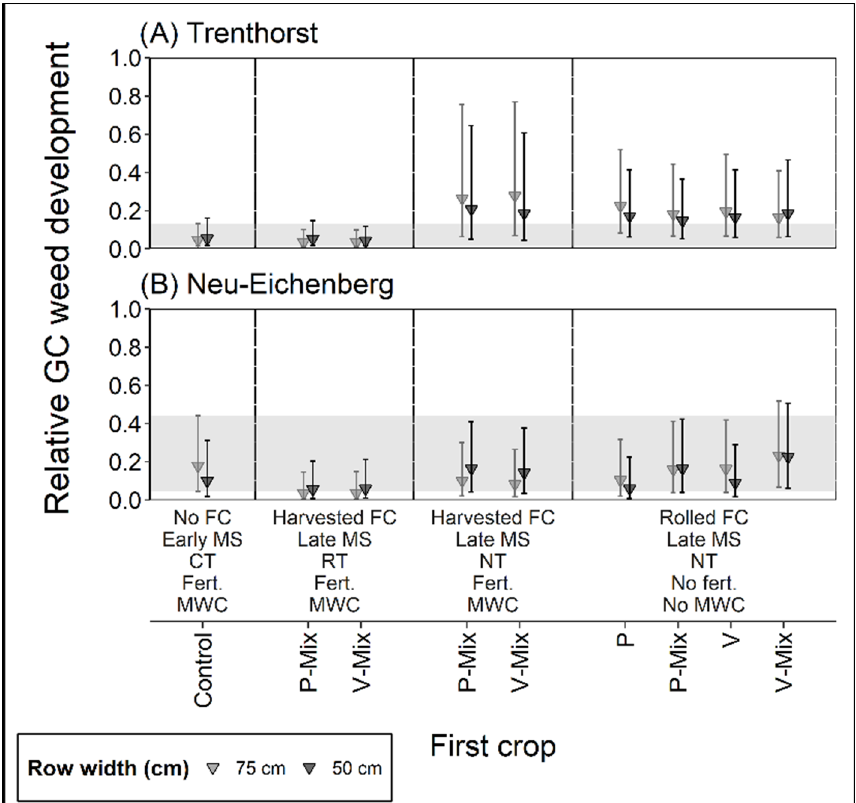
Figure 2. Relative weed groundcover (GC weed ) development over the season averaged over year at the two locations. The x-axis shows the first crop factor (P = winter pea, V = hairy vetch, P-Mix = winter pea and cereal mixture, V-Mix = hairy vetch and cereal mixture) grouped by management (FC = first crop, MS = maize sowing, CT = conventional tillage, RT = reduced tillage, NT = no tillage, Fert. = fertilization, MWC = mechanical weed control). Row width is indicated by colours. Error bars represent the 95% CI of the estimates after multivariate t adjustment. The grey background indicates the 95% CI of the 75 cm SCS for a better comparison. Please note that TRE had DCS NT treatments only in the second year.